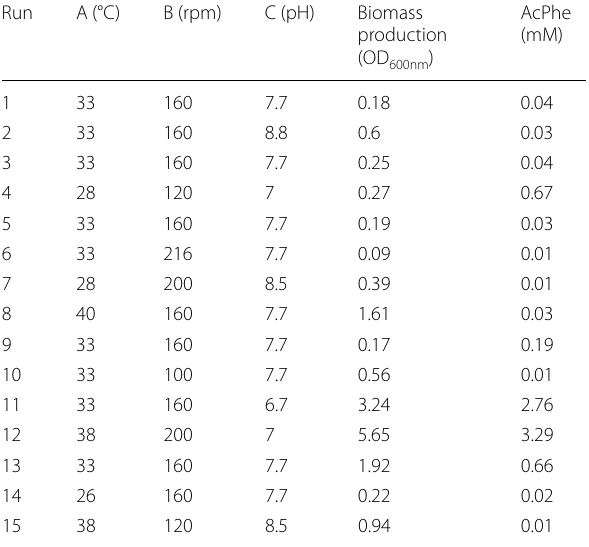
Table 2 Design of experiments for the optimization of medium for biomass and ω-TA production in Bacillus sp. strain BaH, biomass production and AcPhe concentration were considered as a